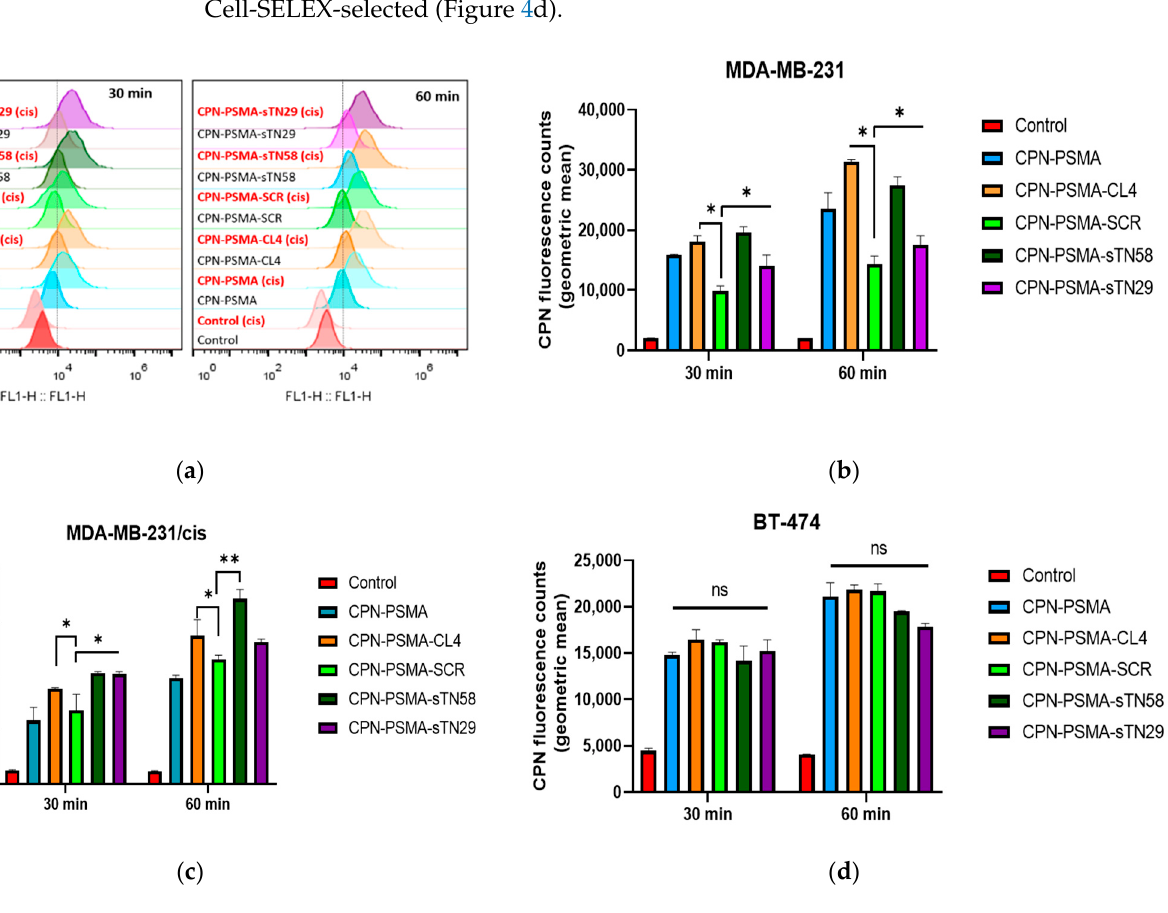
Figure 4. Uptake quantification of aptamer-decorated CPNs by flow cytometry in TNBC cells. ( a ) Representative single-cell emission peaks of MDA-MB-231 and MDA-MB-231/cis cells exposed to CPN suspension (2 mg/L) for 30 and 60 min. Geometric mean fluorescence intensity obtained for MDA-MB-231 ( b ), MDA-MB-231/cis ( c ) and BT-474 cells ( d ). Error bars represent the standard deviation of three independent experiments. * p -value < 0.01 and ** p -value < 0.001 with ANOVA test, ns: no statistically significant differences.